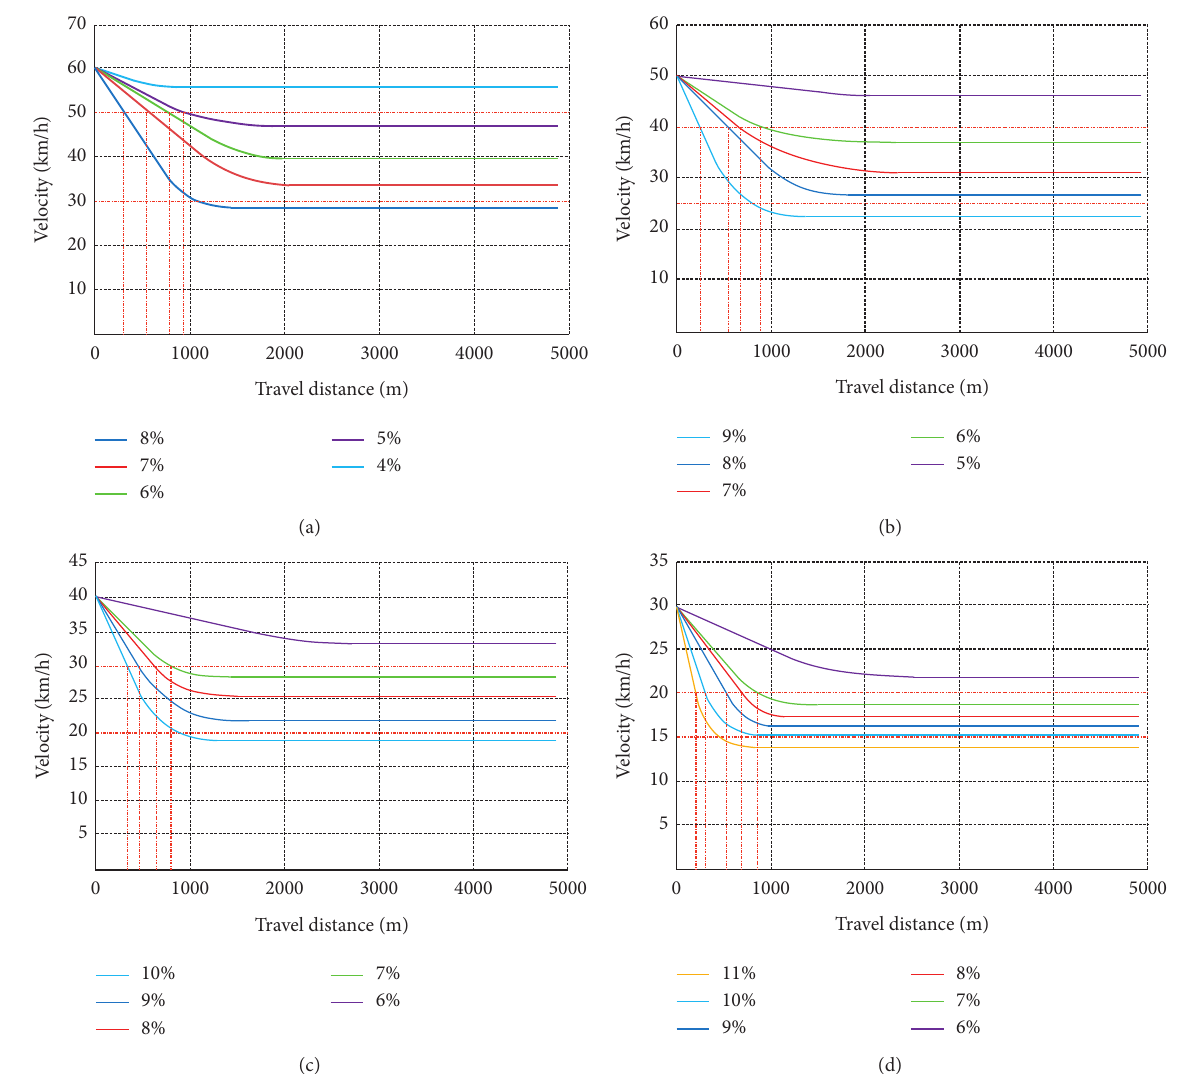
Figure 4: The results of numerical simulation. (a) Simulation results of initial velocity of 60km/h. (b) Simulation results of initial velocity of 50km/h. (c) Simulation results of initial velocity of 40km/h. (d) Simulation results of initial velocity of 30km/h.